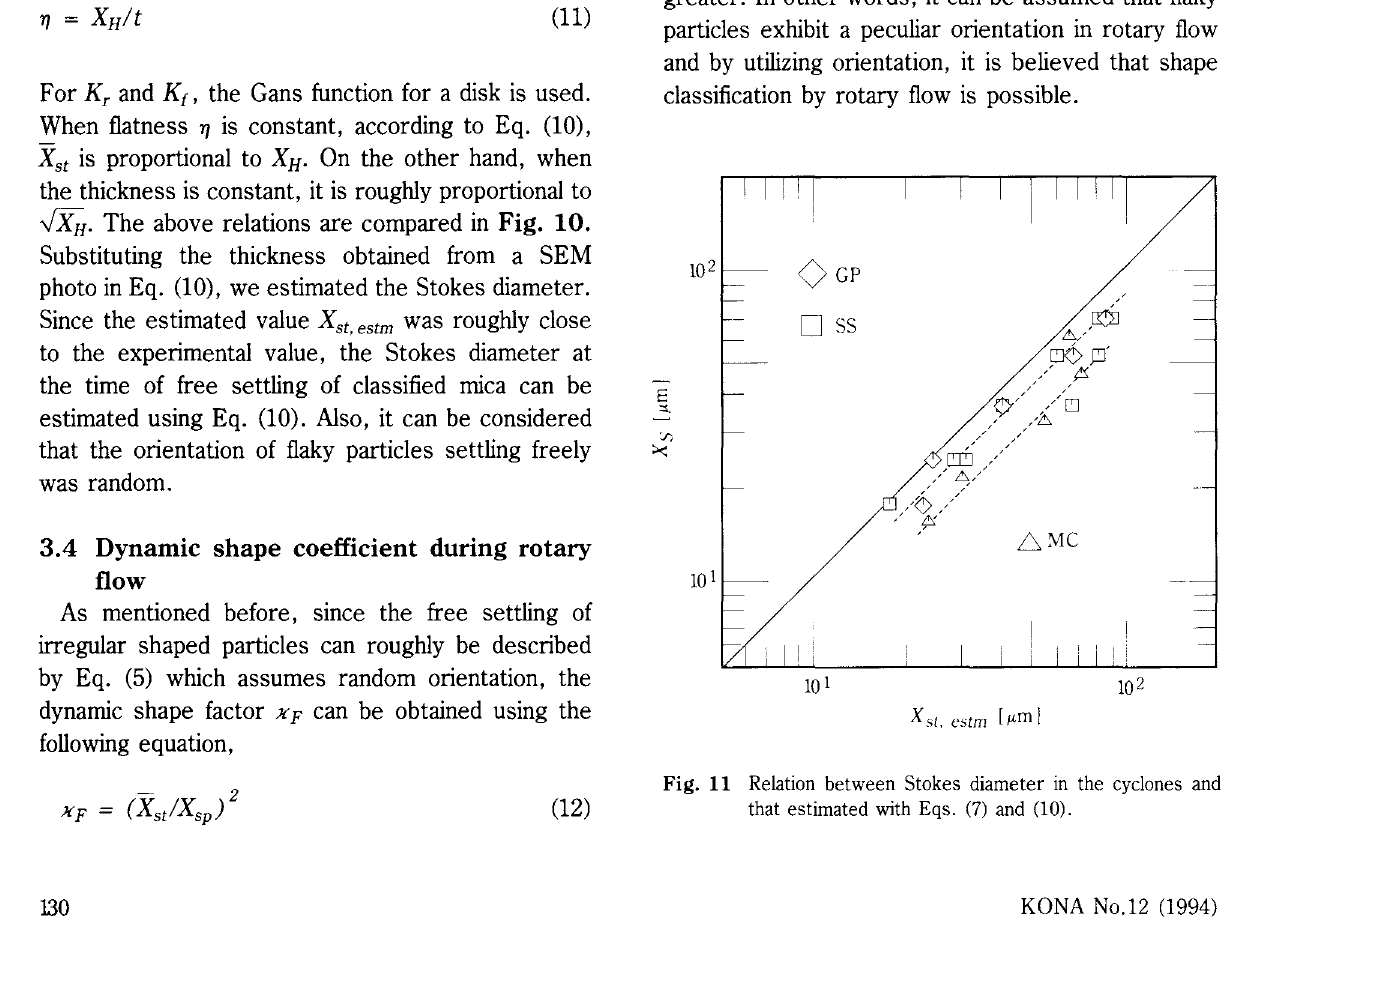
Fig. 10 Comparison of Stokes diameter obtained by photo extinction sedimentation with that estimated by Eqs. (7) and (10) -